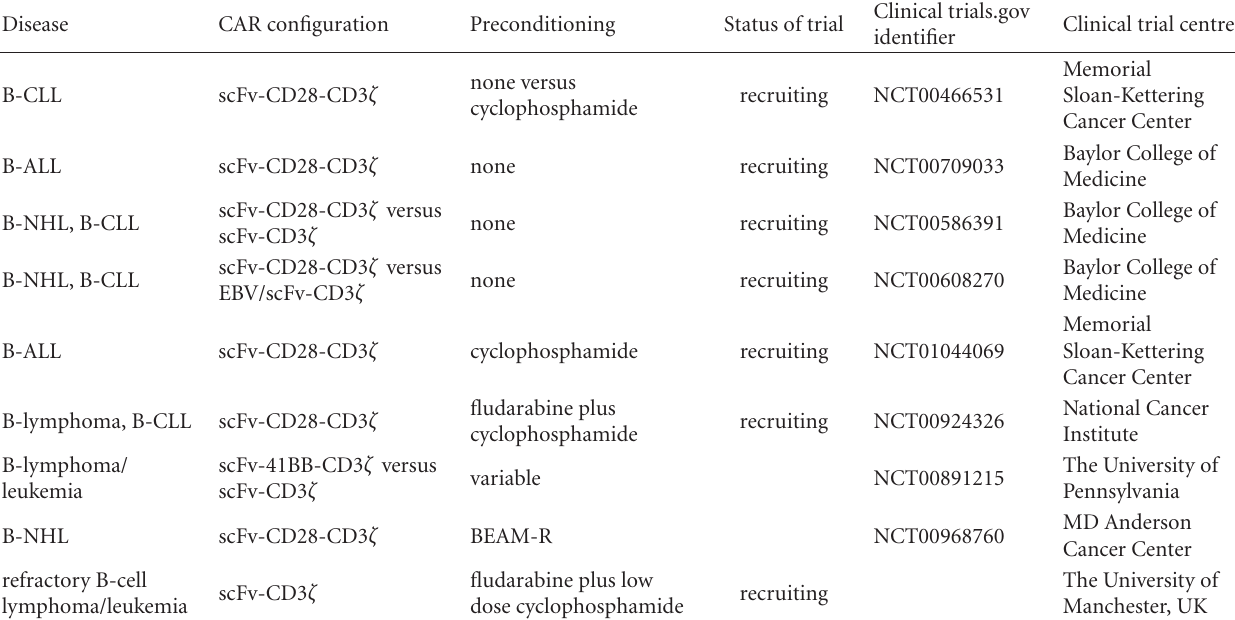
Table 1: Phase 1 clinical trials using anti-CD19 CAR modified T cells for the treatment of B-cell malignancies (updated and adapted from